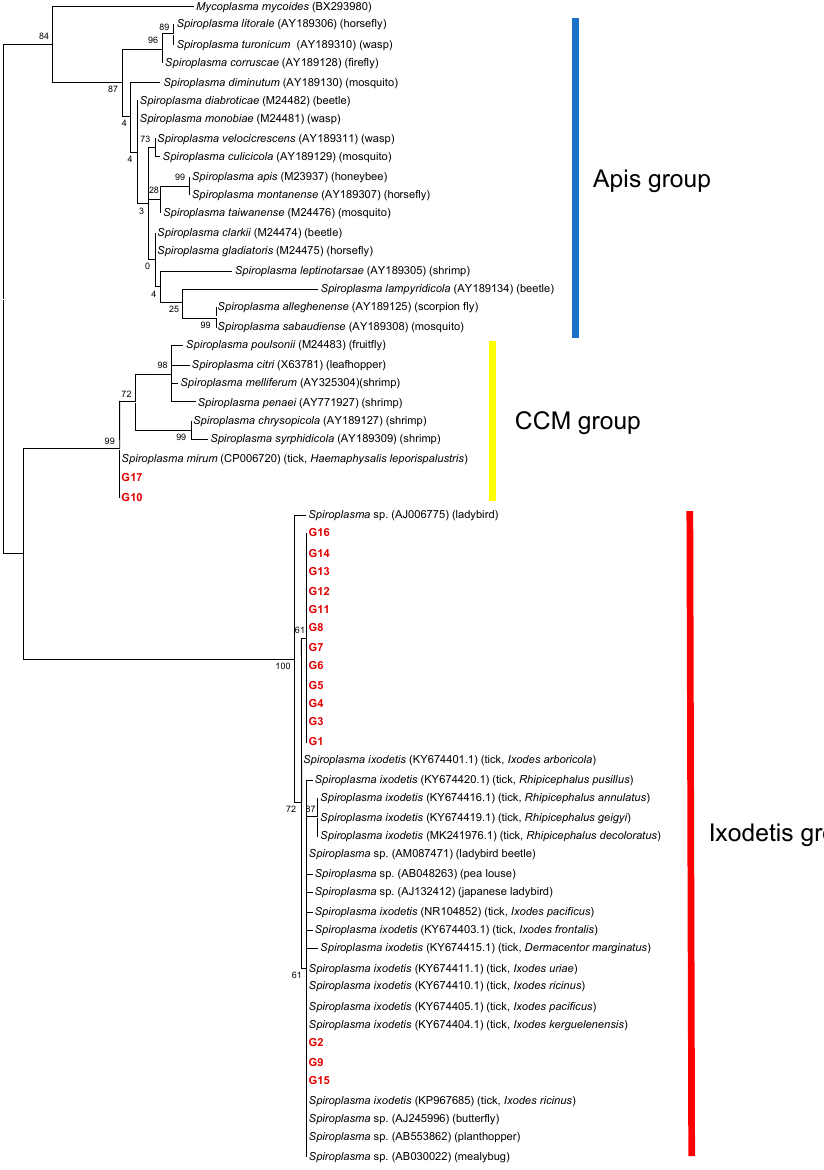
Figure 3. A phylogenetic tree based on the sequences of 16S rDNA. The analysis was performed using a maximum-likelihood method based on the Hasegawa–Kishino–Yano model with bootstrap tests of 1000 replicates in MEGA7. A discrete Gamma distribution was used to model evolutionary rate differences among sites (five categories (+G, parameter = 0.2496)). The sequences obtained in this study are included with allele names provided in Table 2 and are shown in red. The sequences of other Spiroplasma species were retrieved from GenBank. The host is indicated in the parenthesis for each Spiroplasma sequence.